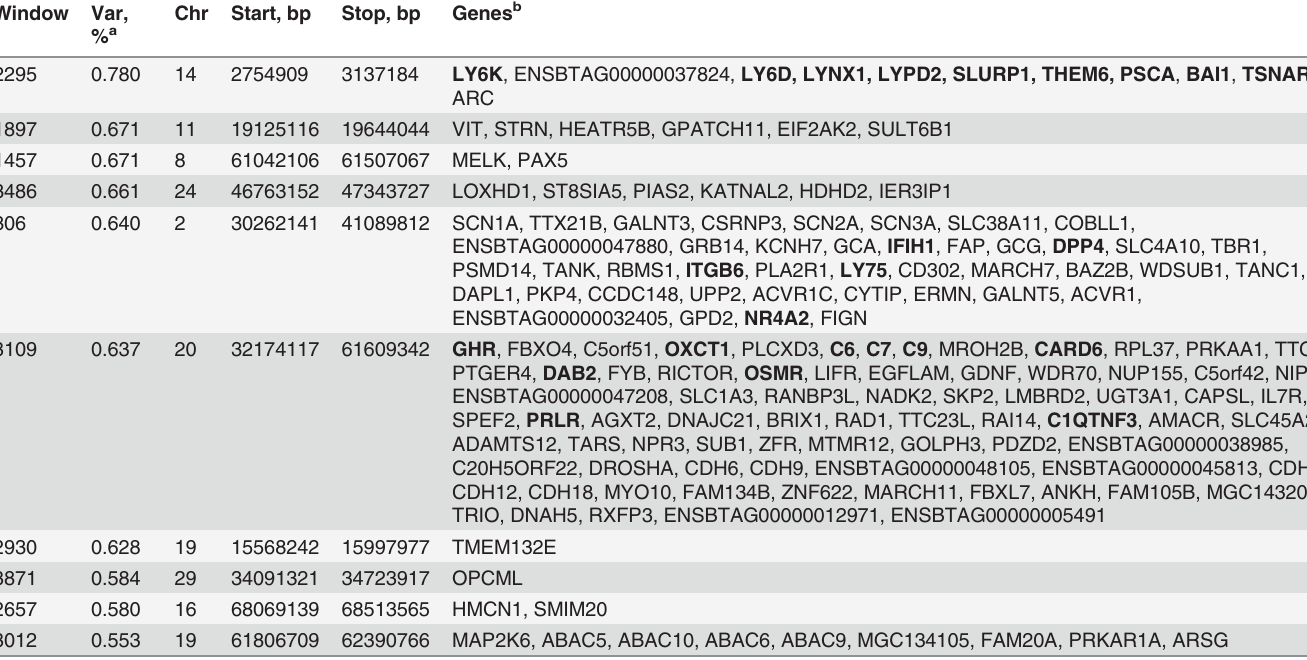
Table 2. Summary of the 10 windows that explained the most of genetic variance for clinical mastitis in US Holstein dairy cows, with a list of annotated genes in the proximity of each window. Window Var, %